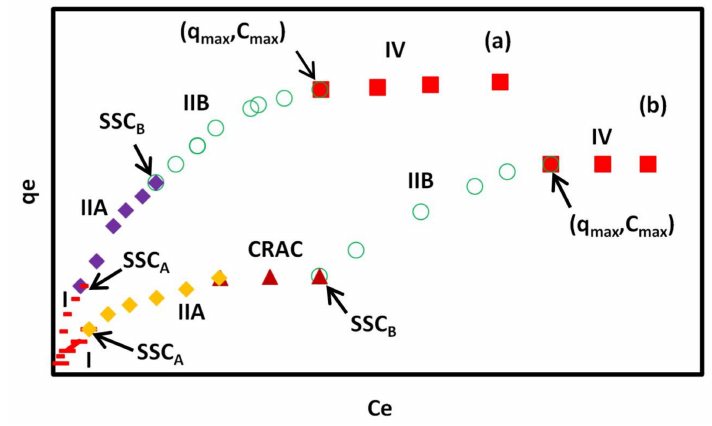
Figure 5. Typical adsorption isotherms of CR on GO/PAMAM nanocomposite in (a) water and (b) alkaline solutions according to the ARIAN model. Symbols –, (cid:7) , regions and CRAC, respectively. CRAC is an abbreviation for “ concentration range of leveling off between two successive adsorption isotherm curves